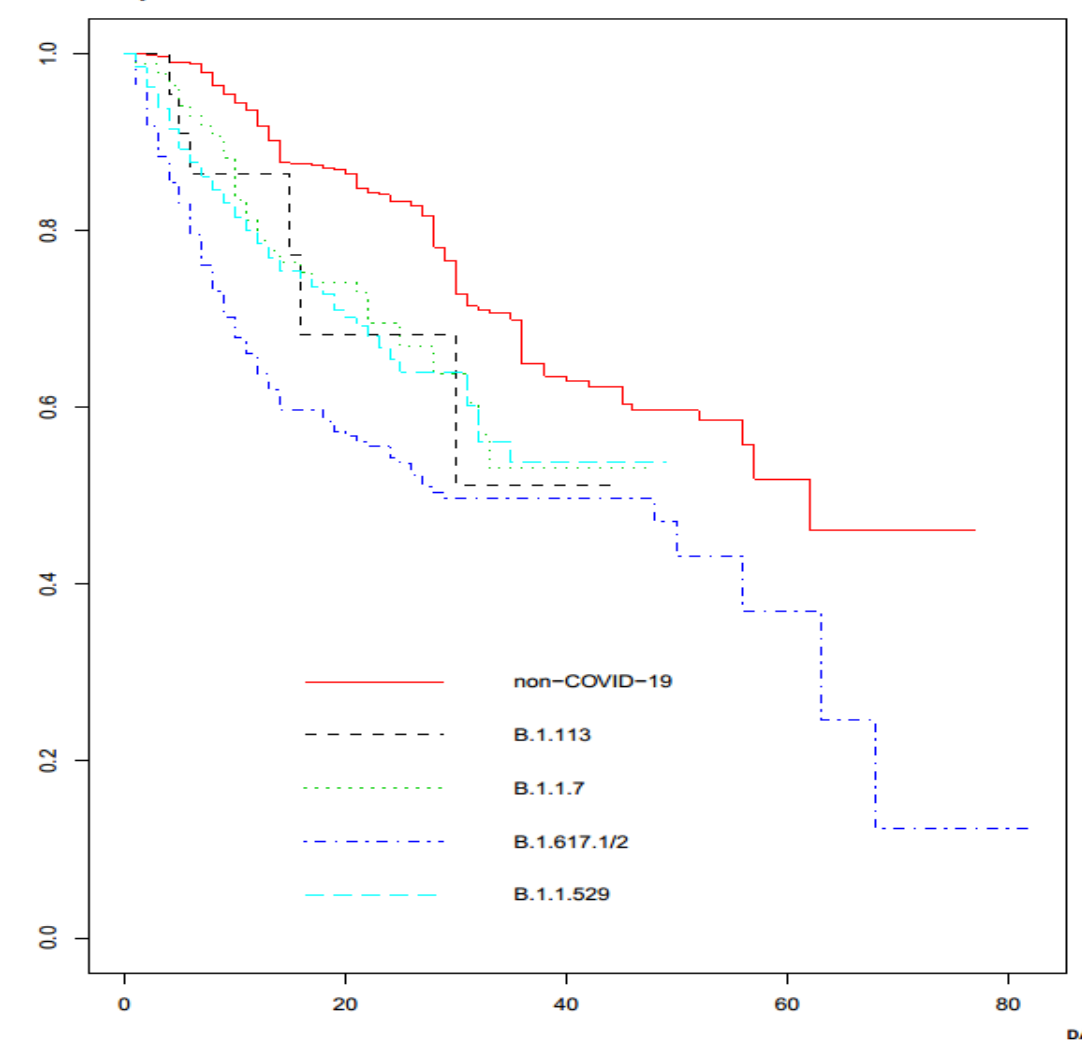
Figure 1. Survival analysis among the patients with community-acquired pneumonia (CAP) due to SARS-CoV-2 variants and other pathogens.